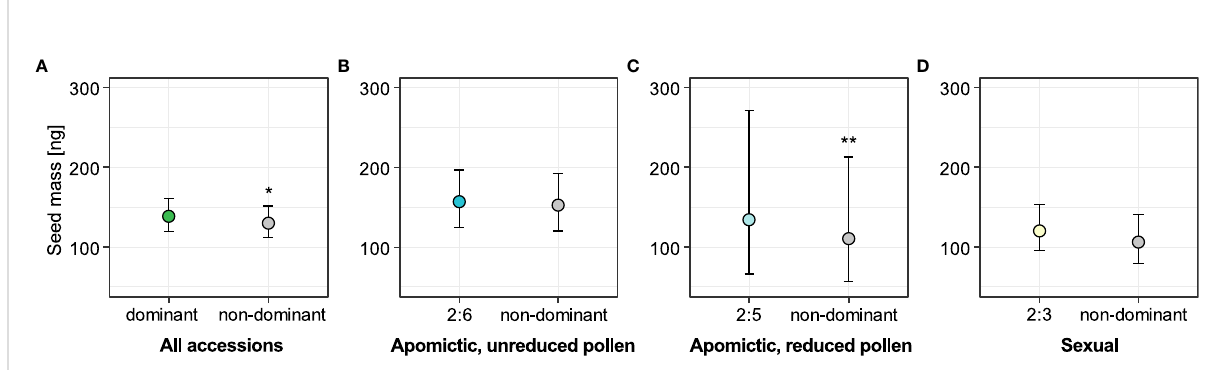
FIGURE 5 Effect of seed type (dominant vs. non-dominant) on seed mass for all accessions (A) and for the three reproductive mode and ploidy groups (B- D) . Sexual accessions produce predominantly seeds with 2x:3x embryo:endosperm ploidy; apomictic accessions with unreduced and reduced pollen produce predominantly 2x:6x and 2x:5x seeds, respectively. Non-dominant seeds are all other seed classes with known embryo and endosperm ploidy in each group. Error bars represent 95% con fi dence intervals. Signi fi cance levels: ∗ < 0.05, ∗∗ < 0.01, ∗∗∗ <